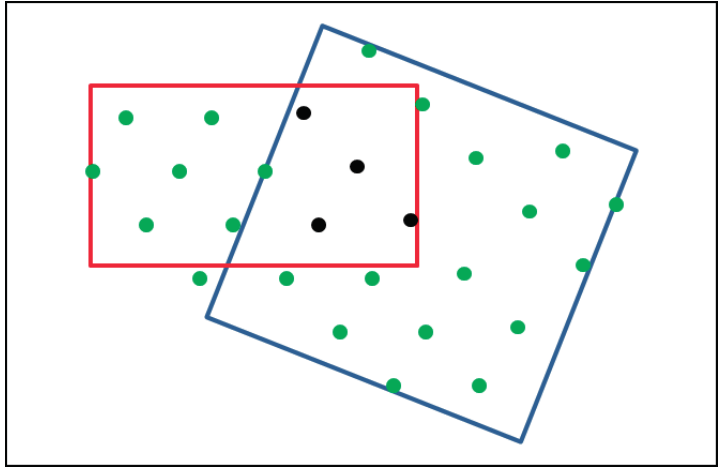
Figure 2. Schematic illustration of the stratified approach for best utilization of existing field data and remote sensing data in large area operational studies. The blue rectangle represents a satellite data scene, the red rectangle is the area with laser scanner data acquired with the same sensor and during the same season and the dots represent clusters with existing field reference plots. When the lidar and satellite data are analyzed together, the plots marked in black show the field reference plots that could be used, whereas all plots covered by the respective data sets (black and green) could be used in the stratified approach where the data sets are analyzed in